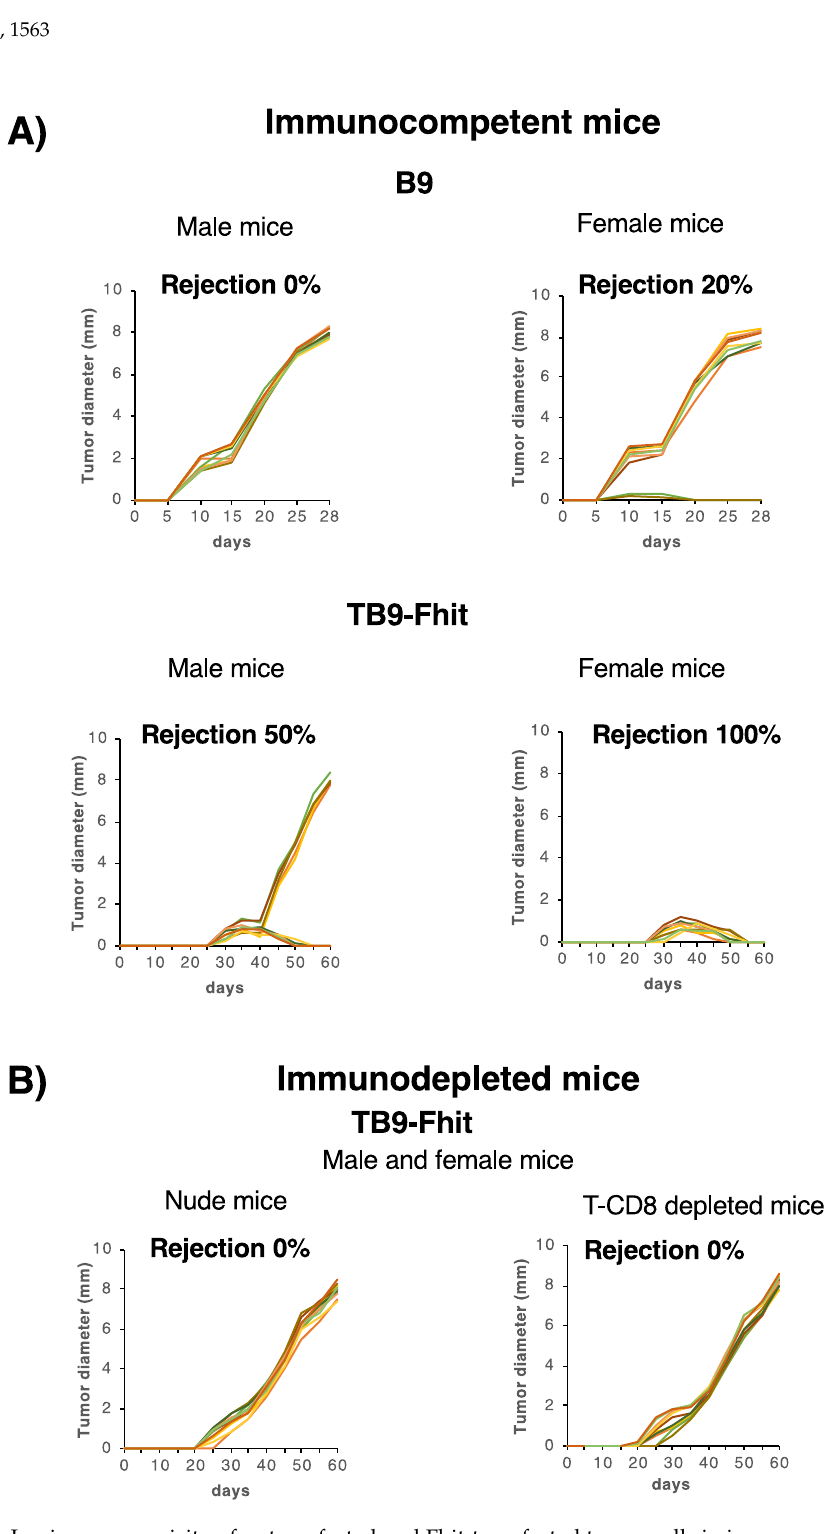
Figure 3. In vivo oncogenicity of untransfected and Fhit ‐ transfected tumor cells in immunocompetent and immunodepleted mice. ( a ) In vivo tumor growth curves ( n = 10 mice per group) of B9 and TB9 ‐ Fhit tumor cells (cell dose 6.25 × 10 5 ) in female/male immunocompetent mice. TB9 ‐ Fhit was rejected in 100% of female mice and 50% of male mice. Fisher’s exact test showed that tumor rejection significantly differed between male and female mice. Assays were repeated twice; ( b ) In vivo tumor growth curves ( n = 10 mice per group) of TB9 ‐ Fhit tumor cells (cell dose 6.25 × 10 5 ) in female nude mice. Identical results were found in male nude mice and in CD8+ T lymphocyte ‐ immunodepleted male/female immunocompetent mice. TB9 ‐ Fhit tumor cells grew in all animals. Assays were repeated twice.